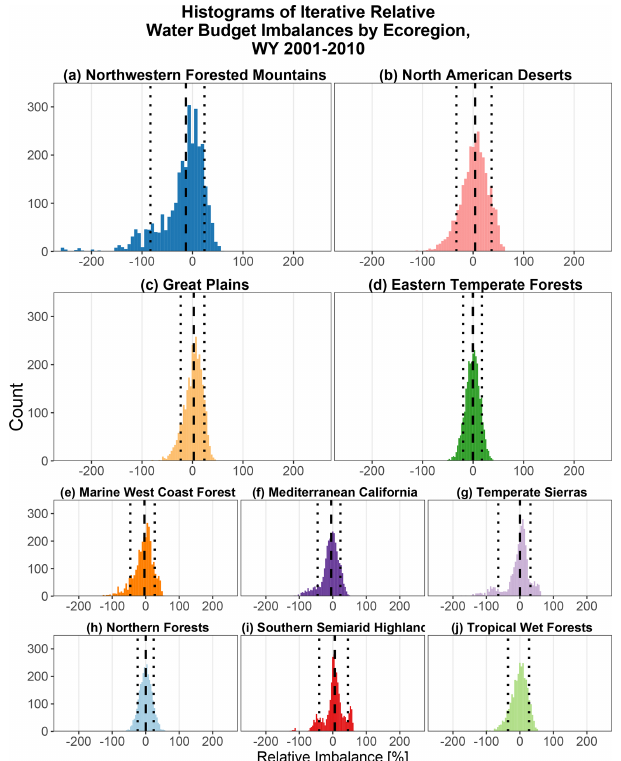
Figure 8. Histograms of 10 ecoregion water budget relative imbal- ances calculated from combinations of all annual precipitation (15), evapotranspiration (15), and runoff (13) data sets with complete data from water years 2001–2010 (Table 1). Each region yielded 2925 water budgets. Relative imbalances are calculated as a per- centage of annual P . The 10th and 90th percentiles of each ecore- gion distribution are provided as vertical dotted lines. Dashed ver- tical lines represent the relative imbalances of 10 year (2001–2010) water budgets from the ensemble mean of all modeled